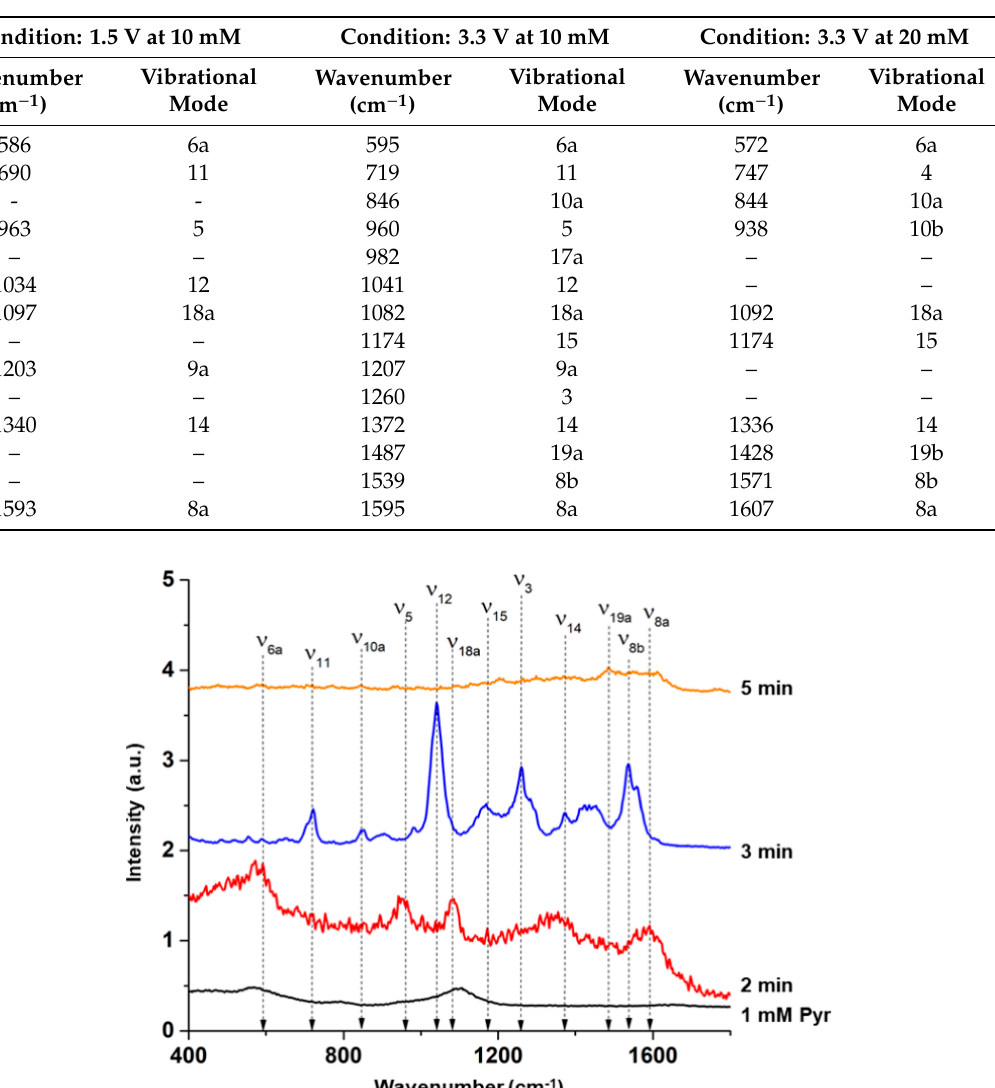
Figure 13. SERS spectra of 1 nM pyridine on supports doped at 2, 3, and 5 min with 10 mM AgNO 3 at